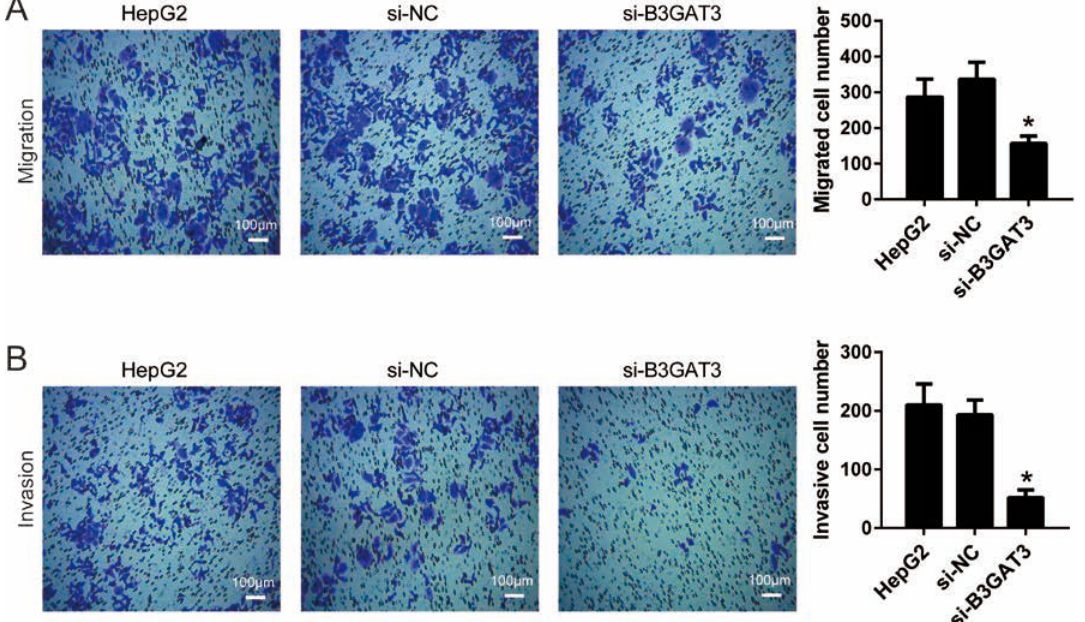
Figure 4: Knockdown of B3GAT3 inhibited the migration and invasion of liver cancer cells. Transwell assay was performed to investigate the effect of B3GAT3 on cell migration (A) and invasion (B). Representative images were captu- red after the transfection for 48 h. Bar = 100 μm. *P<0.05 compared with